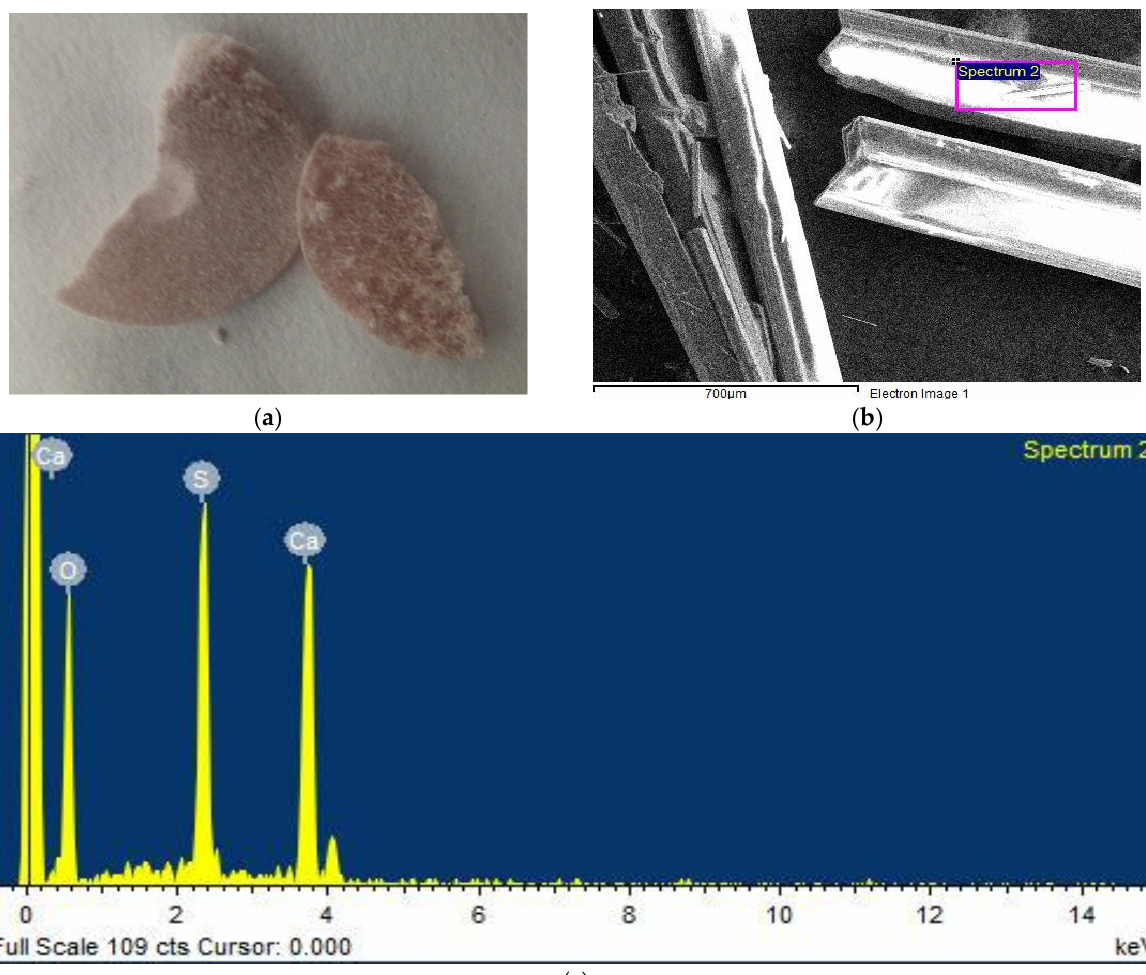
Figure 7. ( a ) Picture of the precipitates in H 2 SO 4 . ( b ) The SEM backscattered image of the precipitate and ( c ) the precipitate EDS.